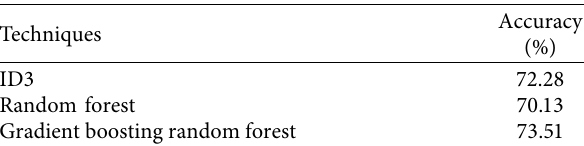
Table 3: The accuracy of different data mining